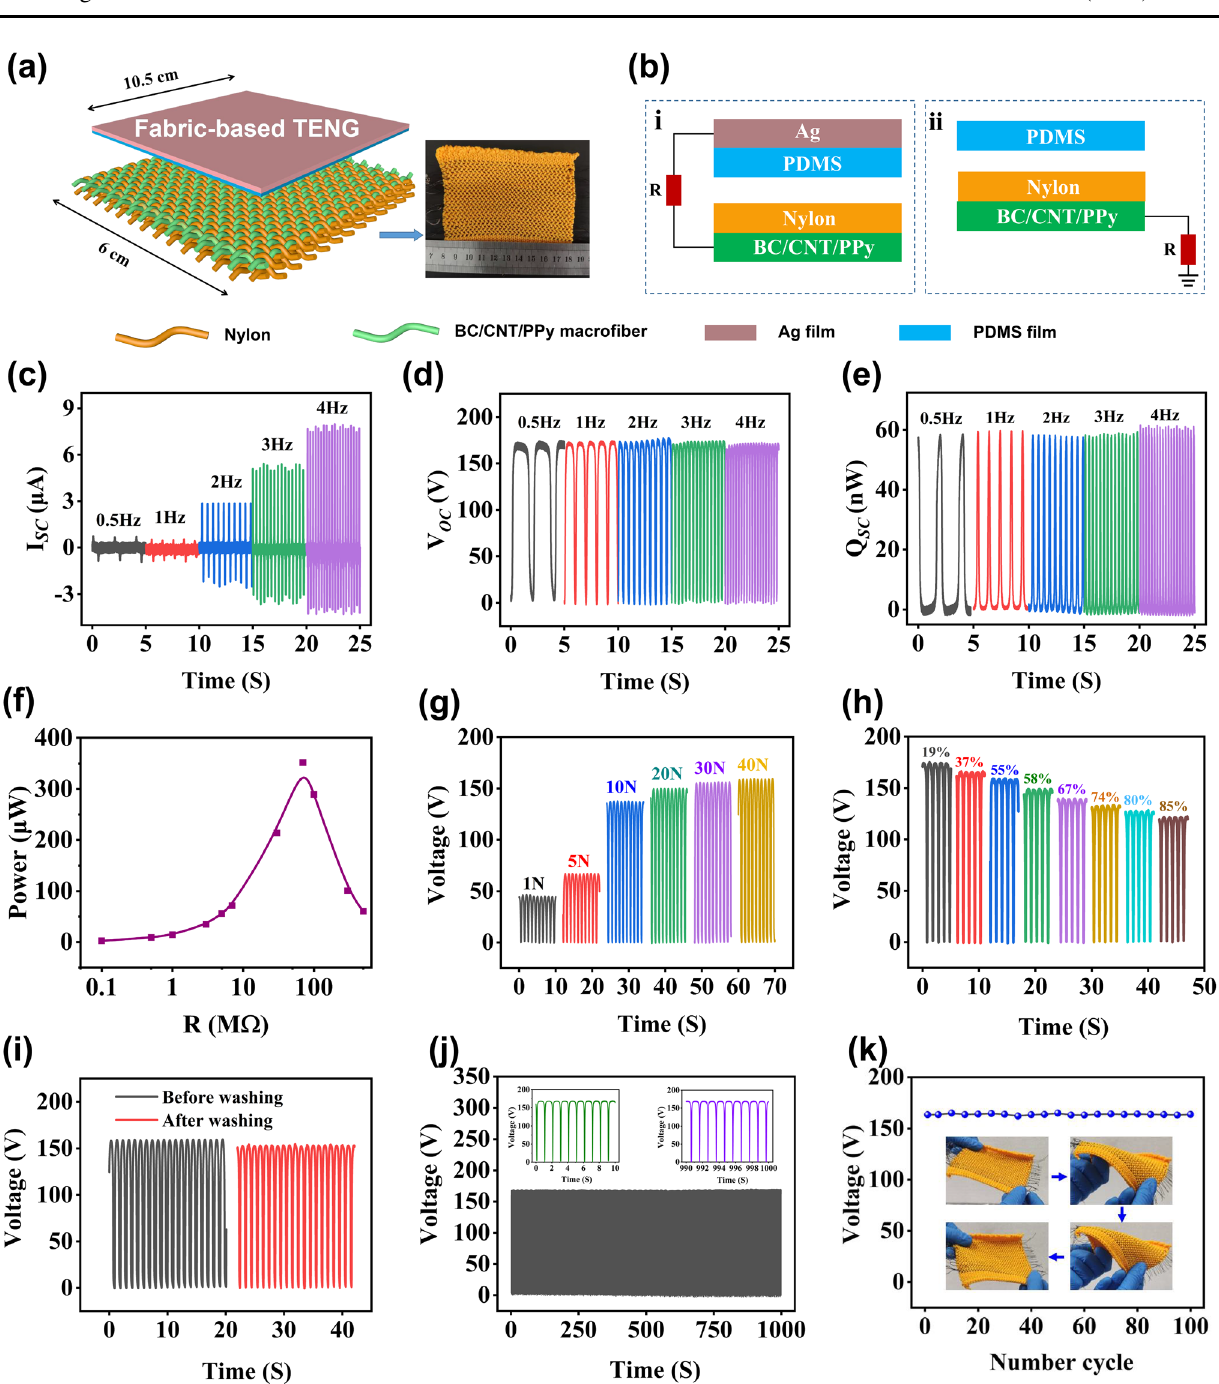
Fig. 5 a Schematic diagram of fabric-based TENG structure; b two working modes of fabric-based TENG, (i) contact-separation mode and (ii) single electrode mode. Electrical output performances and demonstration of the self-charging of the fabric-based TENG. c Short-circuit current, d open-circuit voltage and e transferred charge of the fabric-based TENG in various frequencies. f Instantaneous power as a function of external load resistance. g Output voltage of fabric-based TENG under different applied impact forces at 1 Hz. h Output voltage of fabric-based TENG with varying humidity. i Output voltage of fabric-based TENG before and after washing. j Output voltage of fabric-based TENG within 1000 s at contact-separation frequency of 1 Hz. k Output voltage of fabric-based TENG under 100 cycles of mechanical